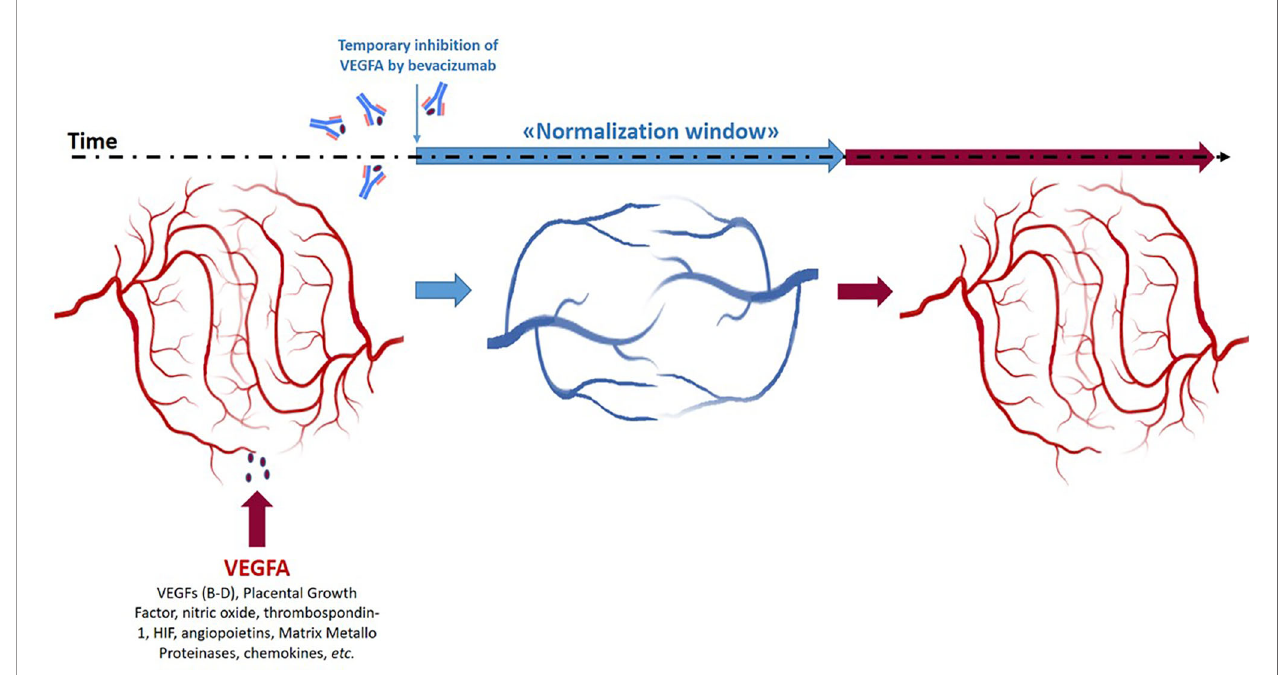
FIGURE 1 | Schematic representation of the “ normalization window ” of anti-angiogenic treatment of tumor masses during time and